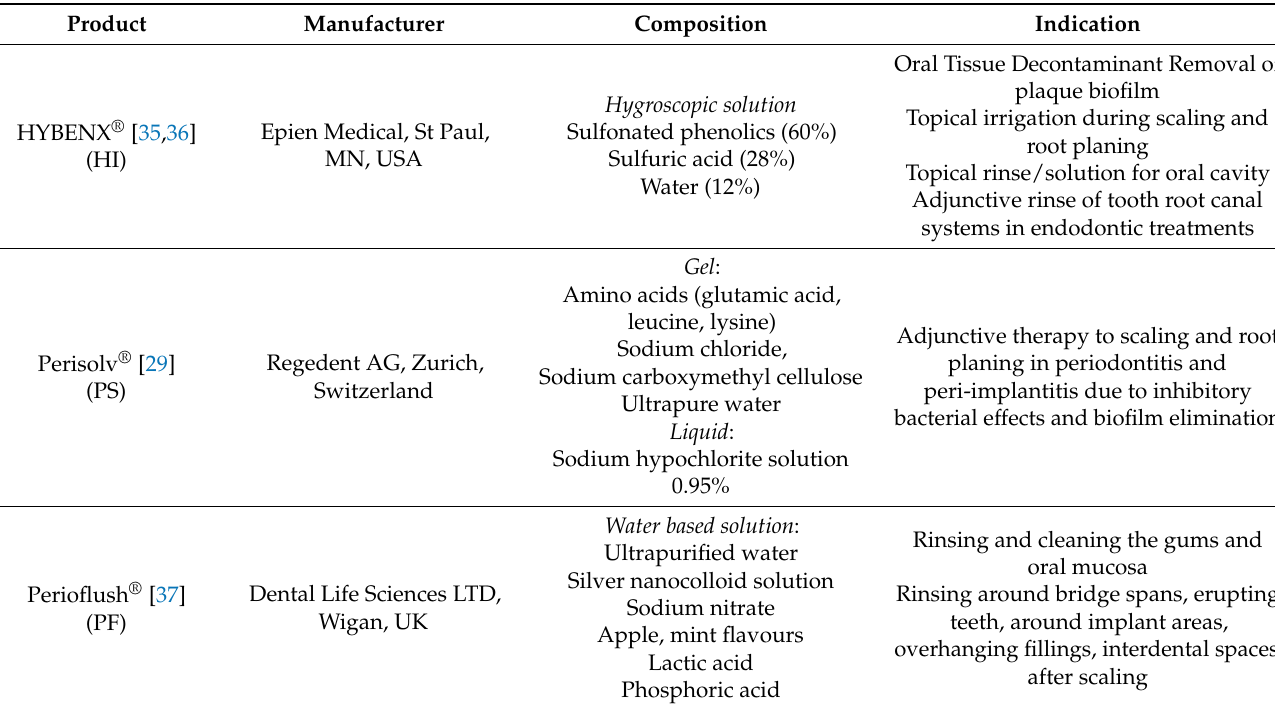
Table 1. Characteristics of the antiseptic